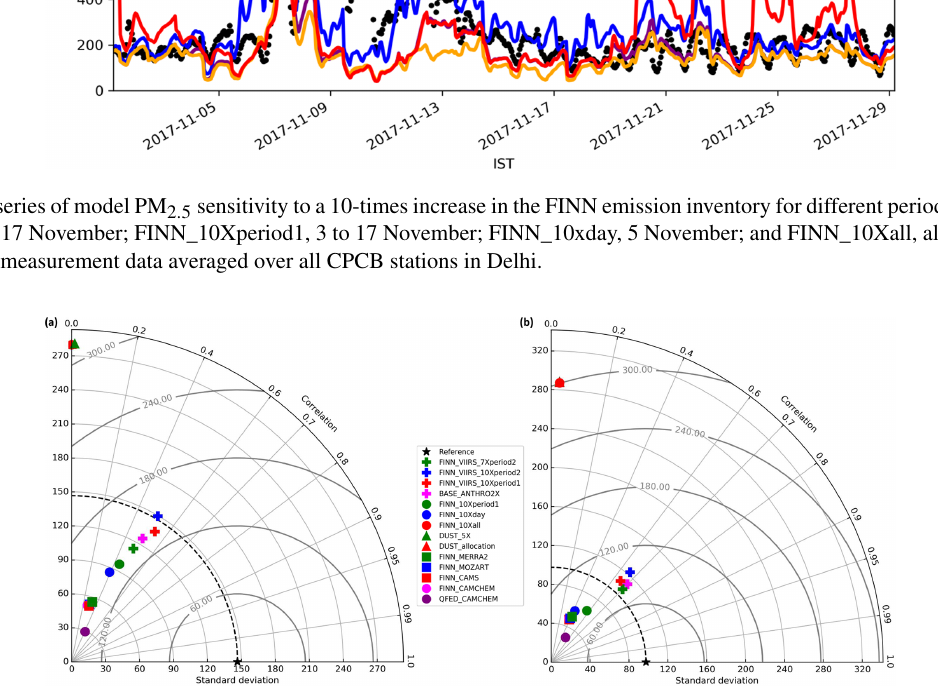
Figure 11. Taylor diagram of hourly PM 2 . 5 concentration based on different simulation scenarios for (a) all the days and (b) all the days except 8, 9, and 10 November. Plus signs denote experiments after incorporating VIIRS data into FINN; circles denote different experiments on the biomass burning emission inventory; triangles denote dust emission experiments; and squares denote chemical boundary condition experiments. Green colors show best performance in each experiment. The black star denotes standard deviation of all CPCB stations averaged in Delhi. The statistics plotted are standard deviation on the radial axis and Pearson’s correlation coefficient ( R ) on the angular axis, and the gray lines indicate normalized centered RMSE